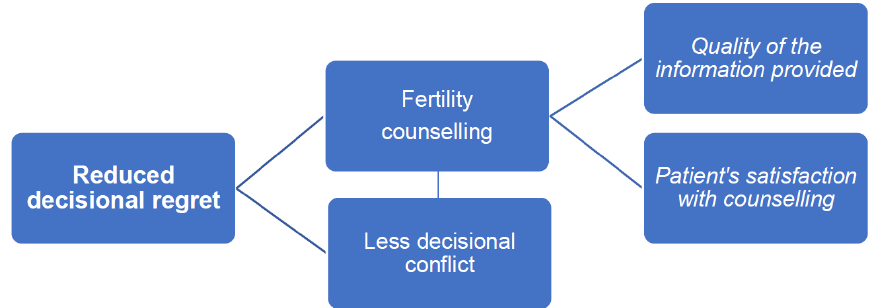
Figure 1. Potentially modifiable factors in clinical practice associated with reduced fertility deci- sional regret.